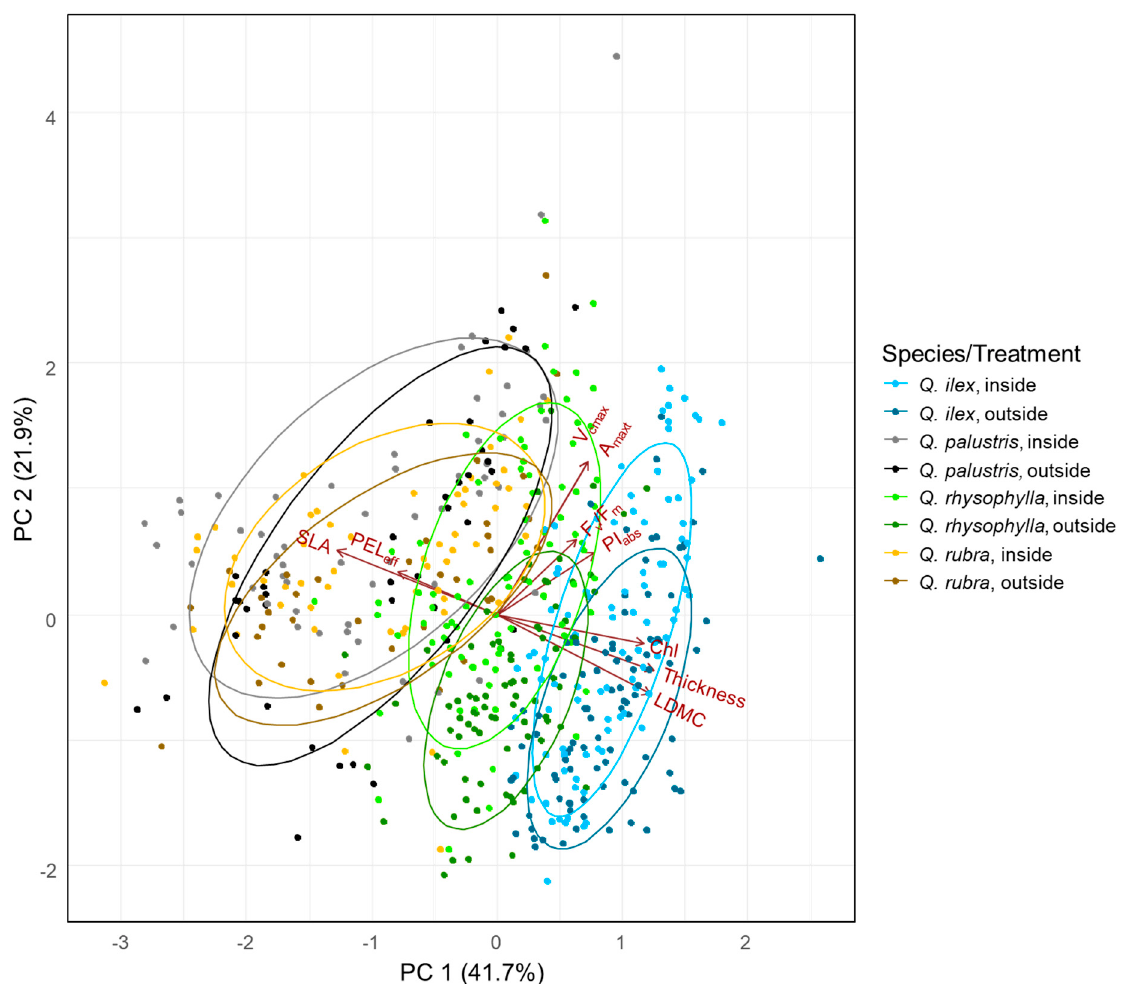
Figure 3. Principal component analysis of all traits, except SPI, and all species selected. Colors represent species and the associated treatment. The evergreen species Q. ilex is displayed in light blue (inside) and dark blue (outside). Q. rhysophylla was colored in light green (inside) and dark green (outside). The deciduous species Q. palustris is shown in light gray (inside) and dark gray (outside) and Q. rubra is displayed in yellow (inside) and brown (outside). Given is the frost resistance measured as effective percentage of electrolyte leakage (PEL eff ), the net CO 2 assimilation rate at saturating irradiance and ambient atmospheric CO 2 concentrations (A max ), the maximum carboxylation rate (V cmax ), the maximum quantum yield of PSII (F v /F m ), the absorption based performance index (PI abs ), the specific leaf area (SLA), the leaf dry matter content (LDMC), the chlorophyll content (Chl) and leaf thickness